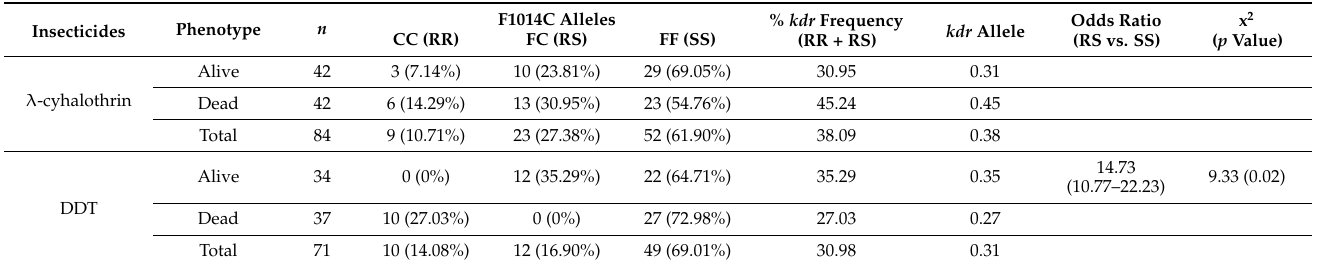
Table 2. Correlation between the 1014C allele frequency and resistance λ -cyhalothrin and DDT resistance phenotype in BUK Aedes aegypti